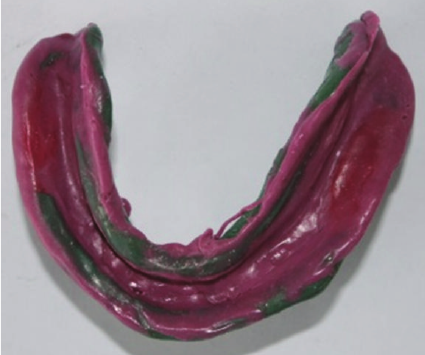
Figure 9: Buccal shelf area recorded with impression compound.